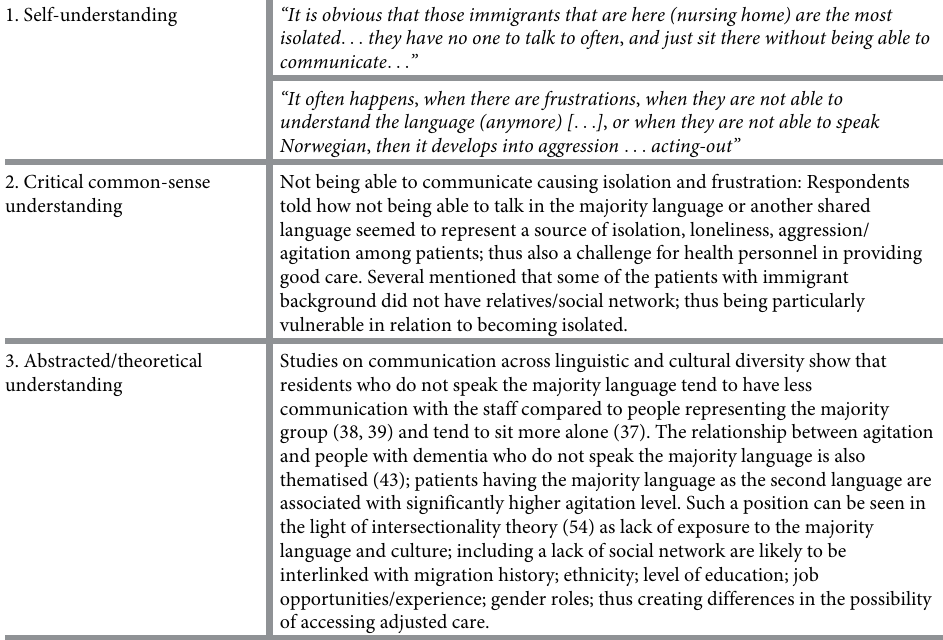
Table 1. Example of the analytical